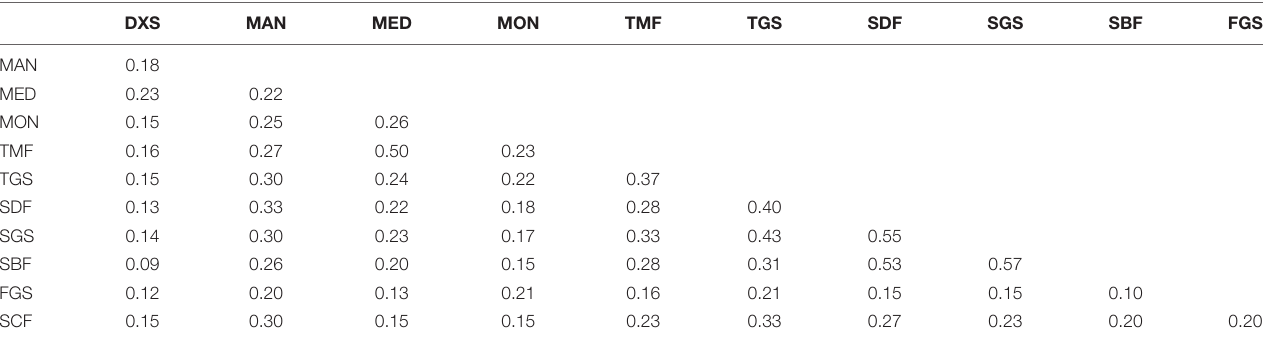
FIGURE 3 | Venn diagram showing the number of species in Glomeromycota that are unique and shared among selected Neotropical biomes. TABLE 2 | Jaccard’s similarity of arbuscular mycorrhizal fungi species between biomes of the Neotropical biogeography